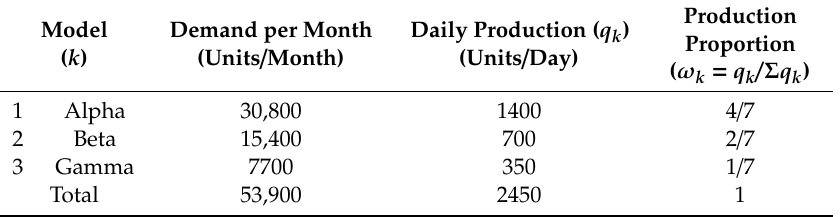
Table 2. Daily schedule.